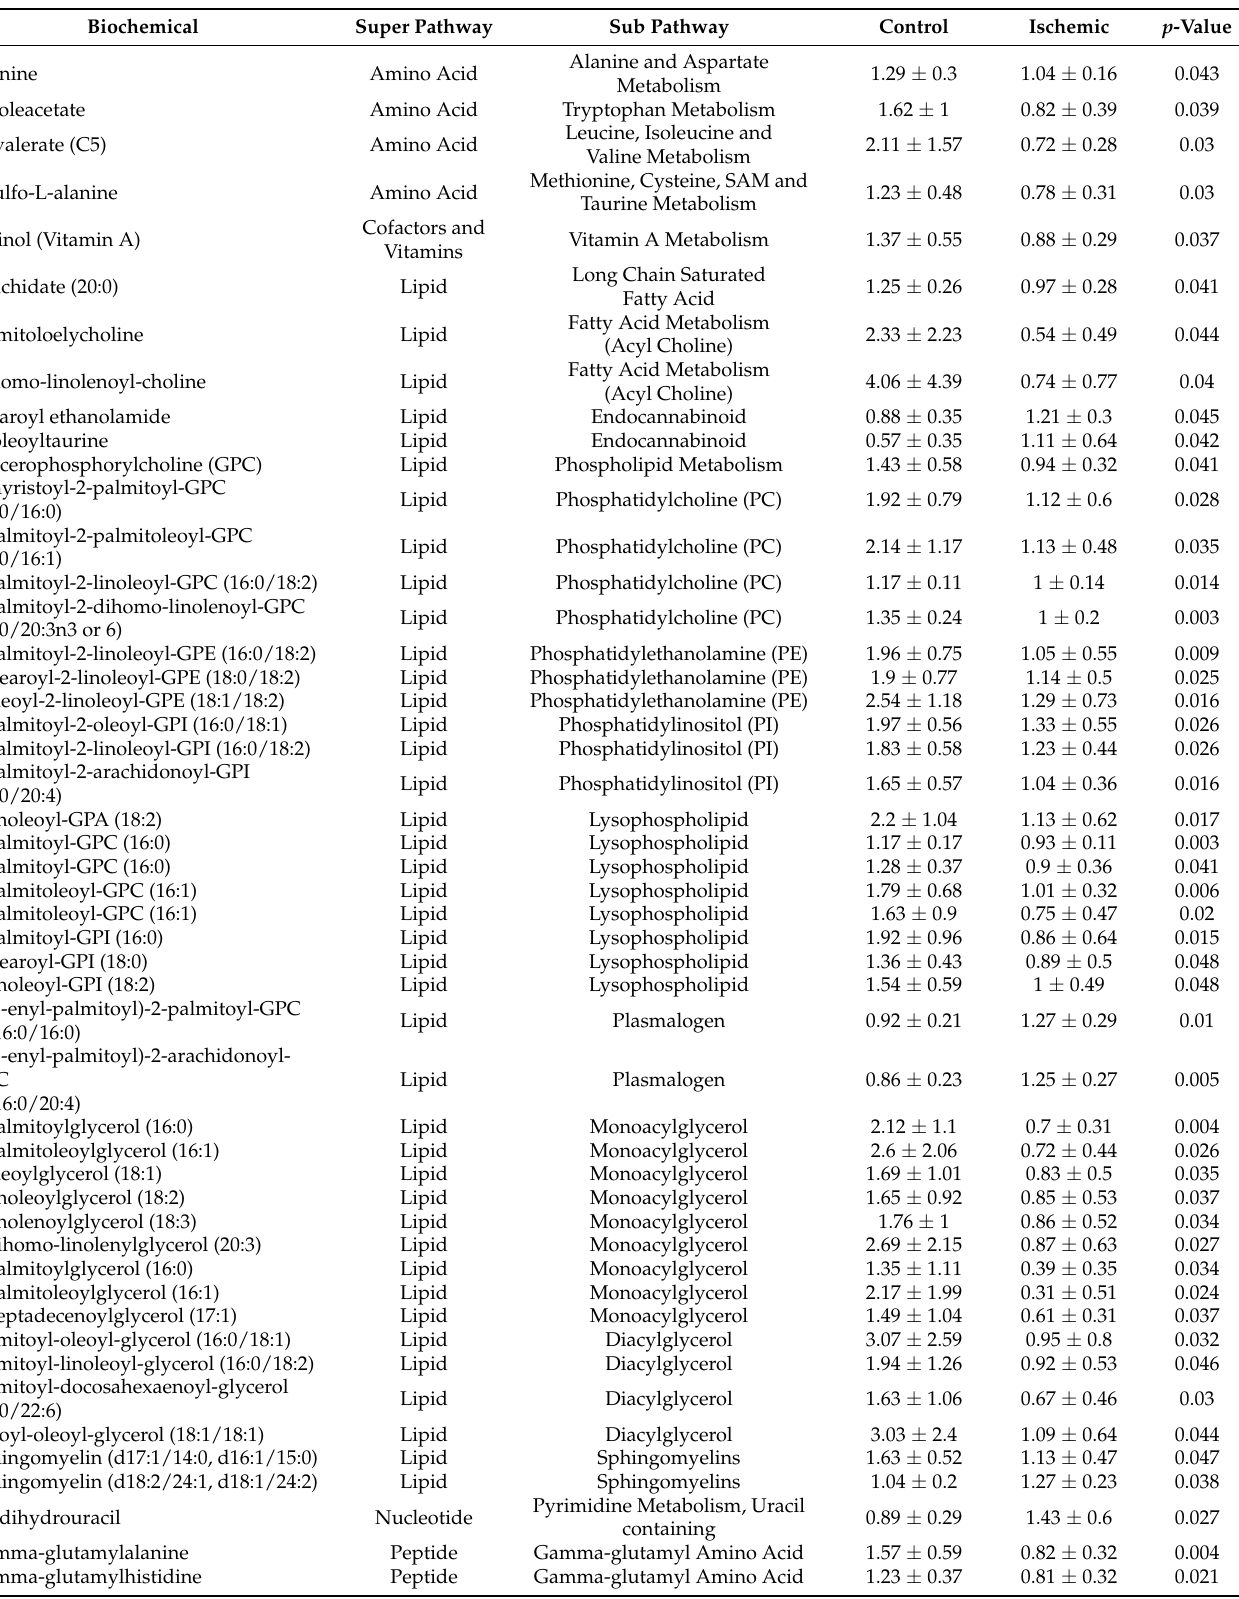
Table 1. Metabolite differences between ischemic stroke patients and control patients in the female